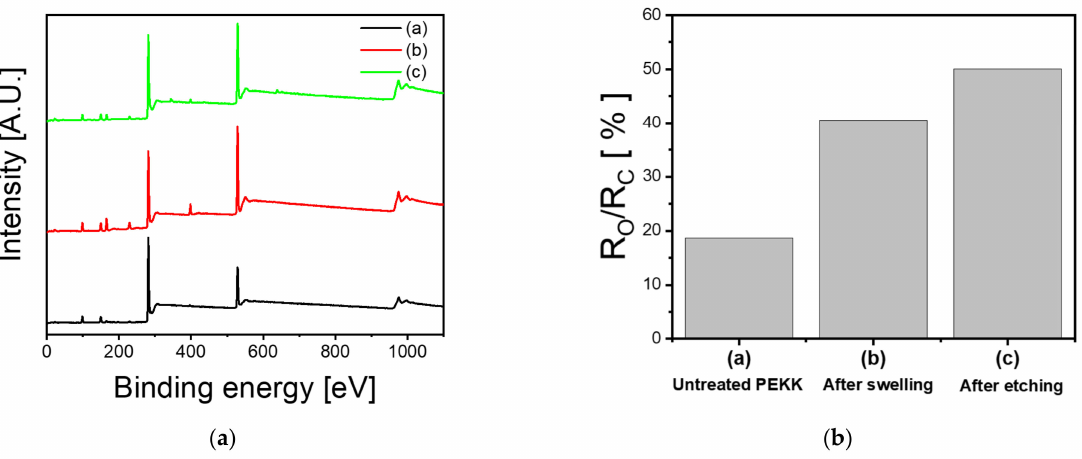
Figure 5. XPS survey spectra and carbon–oxygen content ratios of 3D printed PEKK samples: ( a ) XRD survey spectra; ( b ) Ratio of C1s and O1s peak for the prepared samples.